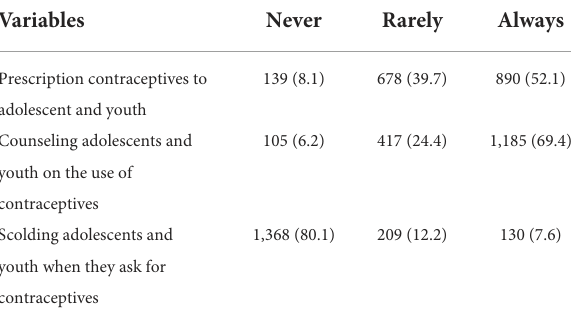
TABLE 4 Provider practices regarding contraceptive use among adolescents and youth, Guinea, January-March 2021 ( n =